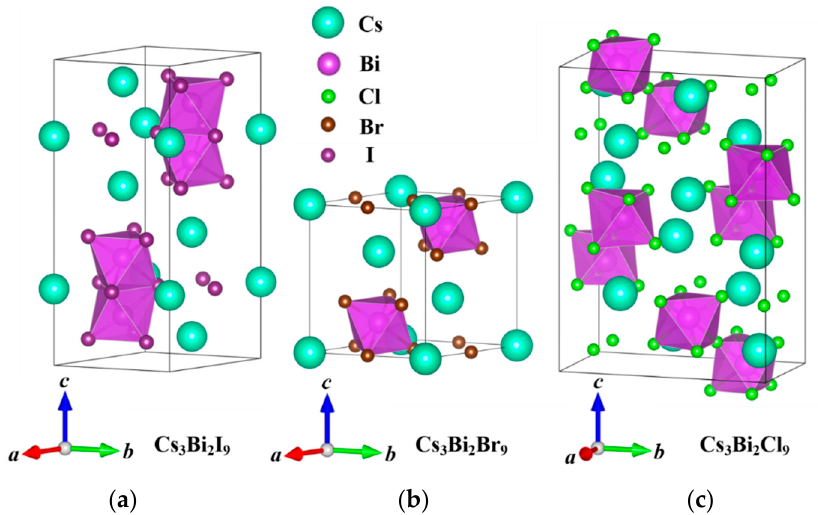
Figure 1. Crystal structures of the zero-dimensional perovskite Cs 3 Bi 2 I 9 ( a ), two-dimensional perovskite Cs 3 Bi 2 Br 9 ( b ), and one-dimensional perovskite Cs 3 Bi 2 Cl 9 ( c ).